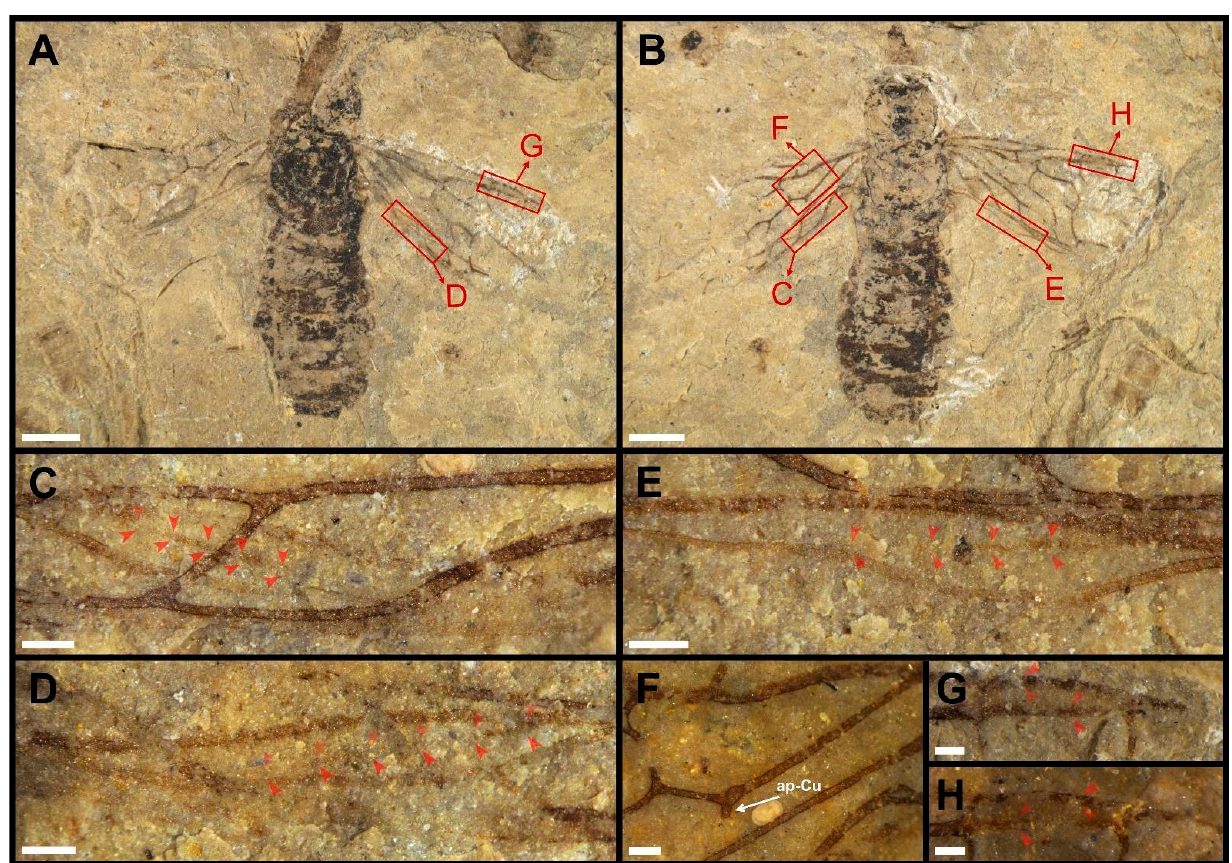
Figure 3. Dolicholyda obtusata gen. et sp. nov., Paratype (CNU-HYM-ND2022106p/c), sex unknown. ( A ), dorsal view. ( B ), ventral view. ( C – E ), Sc in hind wing. ( F ), ap-Cu in forewing under alcohol. ( G ), pterostigma. ( H ), pterostigma under alcohol. Arrows in red mean the venations here are highlighted. Scale bars: 2 mm in ( A , B ); 0.25 mm in ( C – H